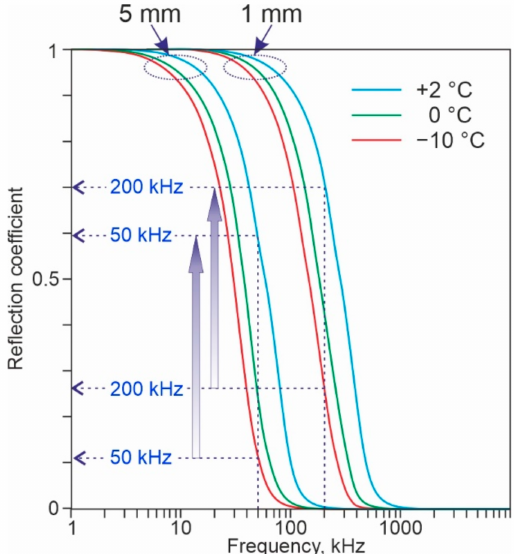
Figure 7. Frequency dependence of a normalized reflection coefficient from a rough sandstone surface, calculated for temperatures of 2 ◦ C (1), 0 ◦ C (2) and − 10 ◦ C (3) and roughness heights of 1 and 5 mm. The vertical violet arrows show roughness-related reflection coefficient increase as the sand cools down from +2 to − 10 ◦